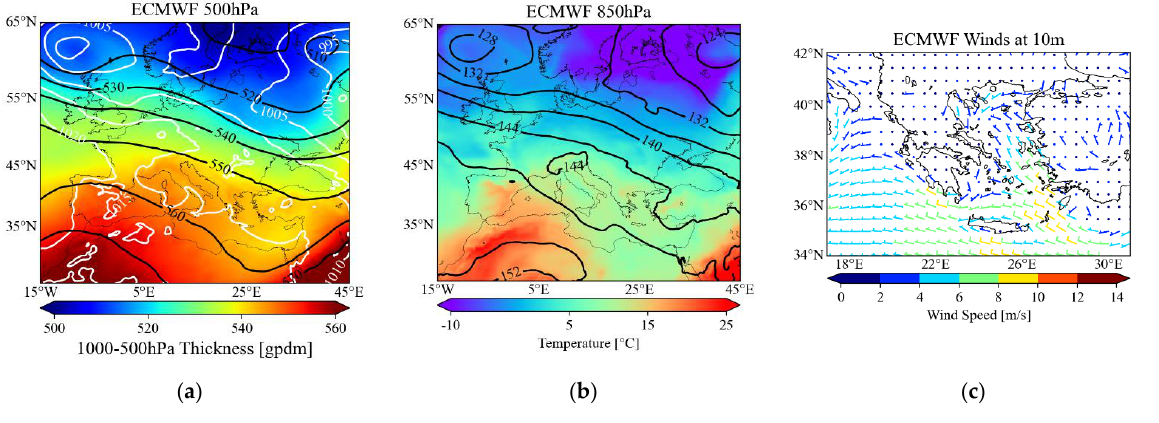
Figure 9. ECMWF Reanalysis Data for 14 April 2017, ( a ) 18:00 UTC 500 hPa Geopotential Height (black lines), MSLP (white lines), 1000 – 500 hPa Thickness, ( b ) 18:00 UTC 850 hPa Geopotential Height (black lines), 850 hPa Temperature, ( c ) 06:00 UTC 10 m Wind Speed and Direction.